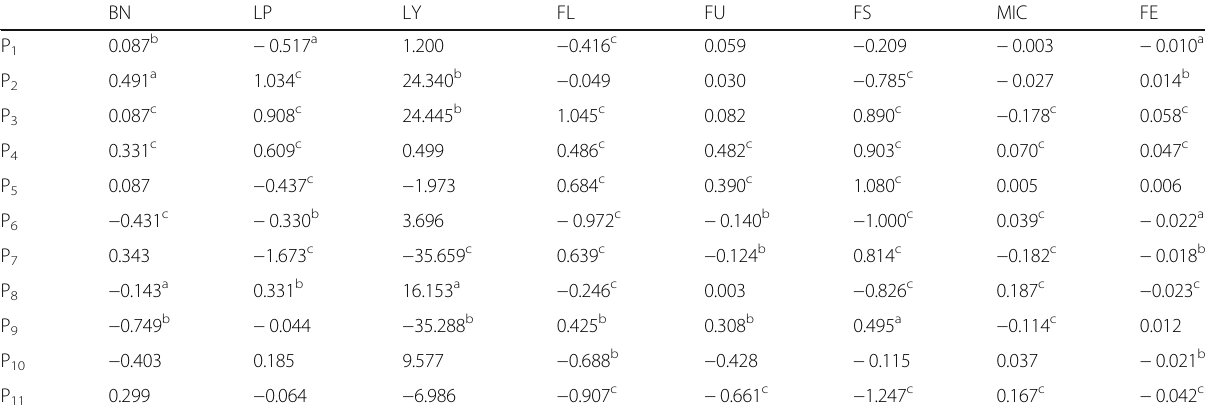
Table 1 Predicted additive effects for yield, yield components, and fiber quality